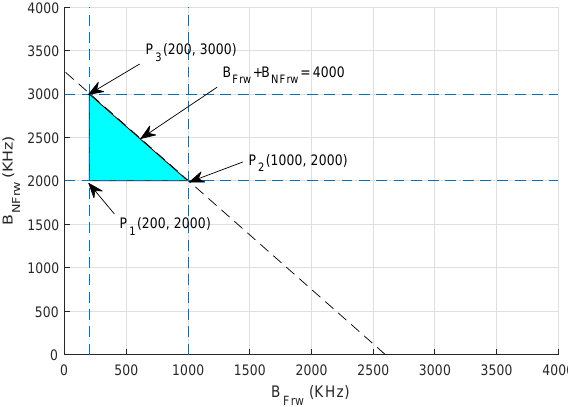
Figure 6. Feasible region: throughput